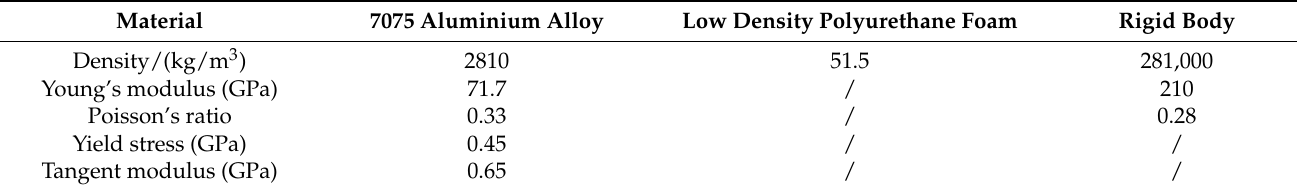
Table 1. Parameters of the